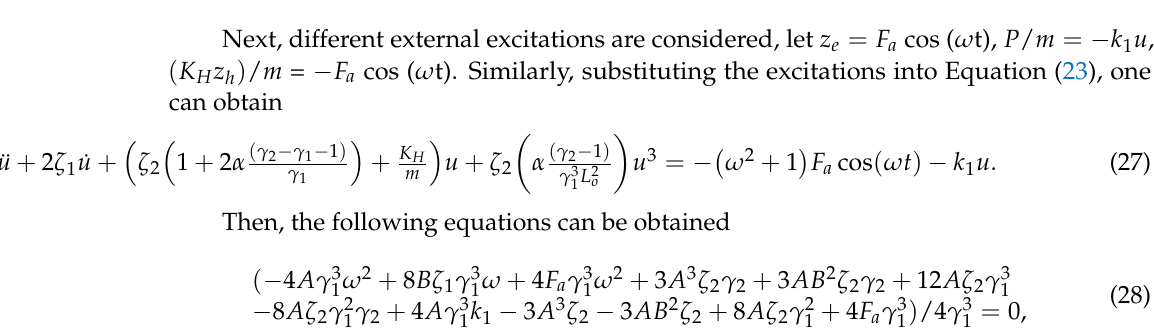
Figure 7. Amplitude and frequency response curve for various ( a ) γ 2 and ( b ) ζ 1